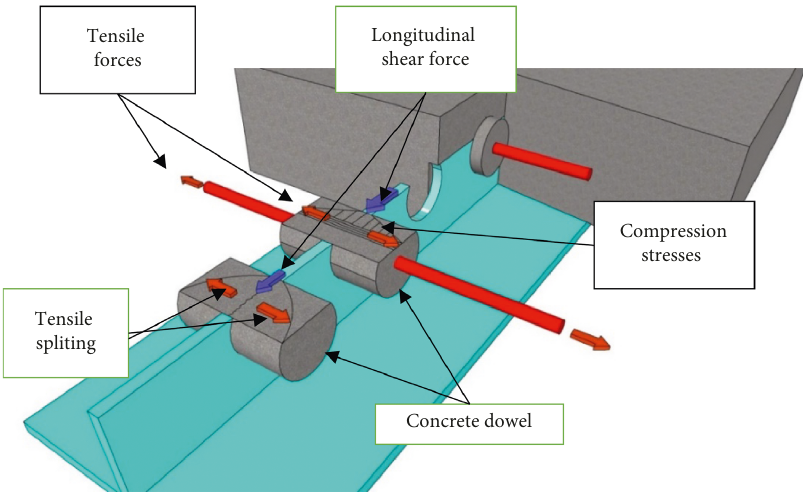
Figure 13: Forces distribution in concrete dowel.